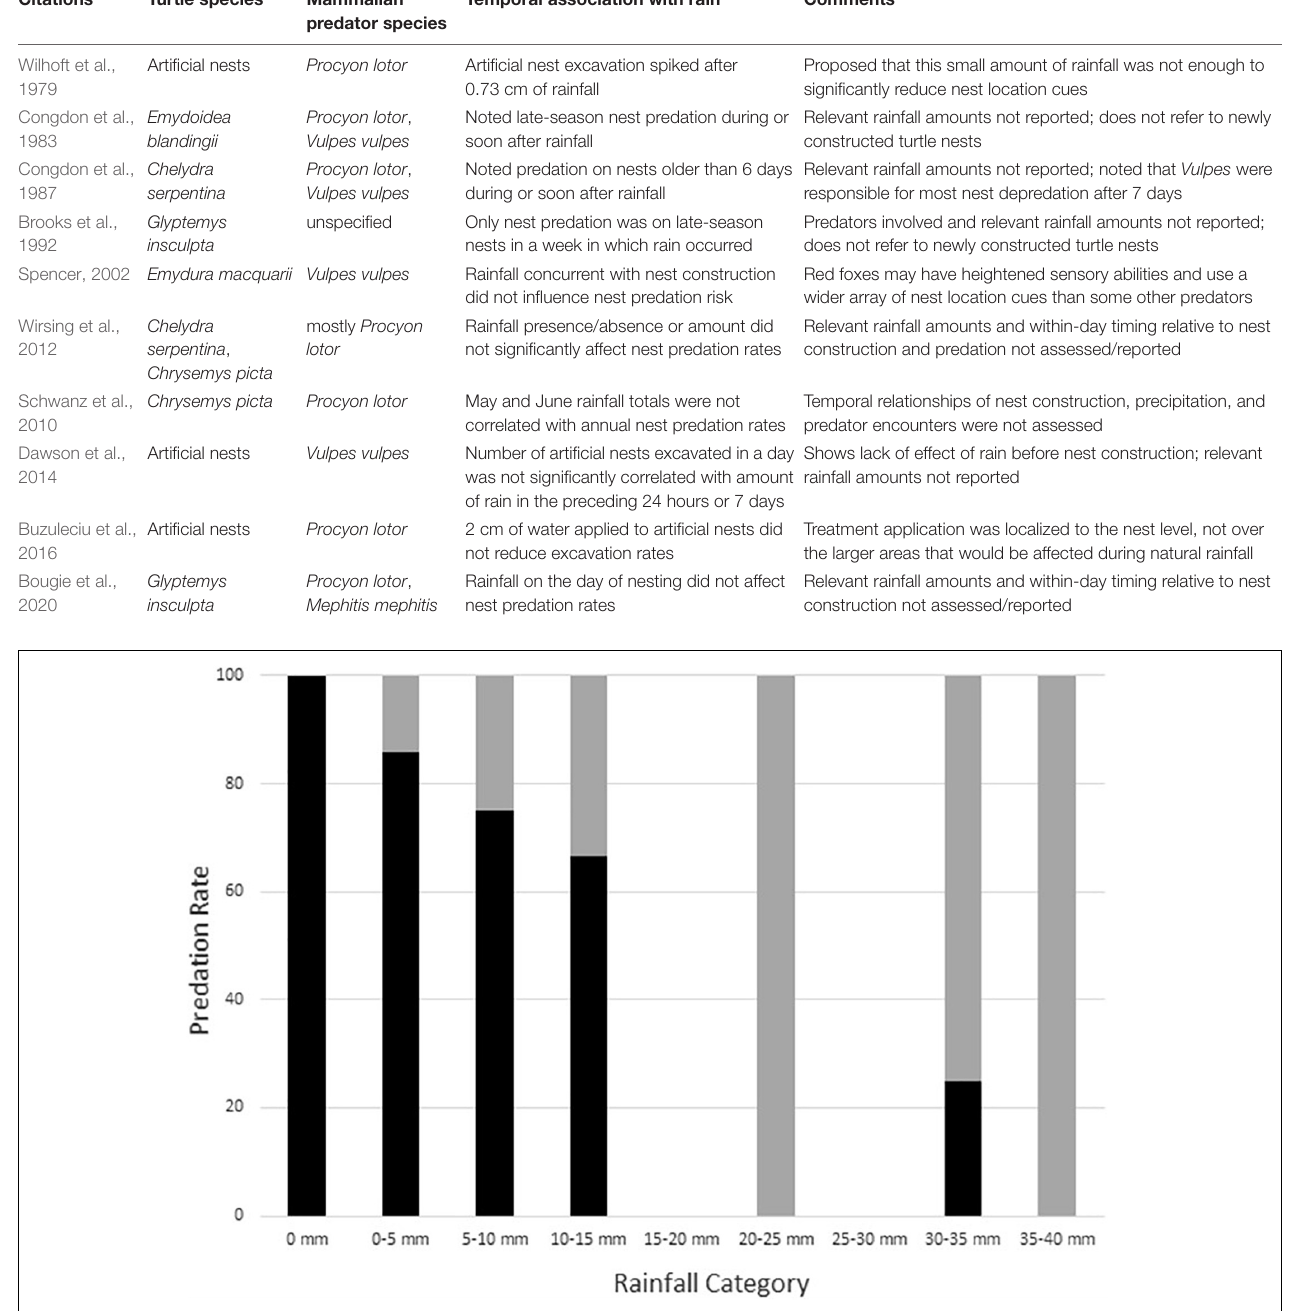
FIGURE 3 | Association of 4-day cumulative rainfall amount with rates of nest depredation (black bars; n = 116) and nest survival (gray bars; n = 9) for natural Graptemys ouachitensi s nests along the Wisconsin River, WI, United States, during 12 study years from 2008 to 2021. Most nests depredated during the first night (see text for